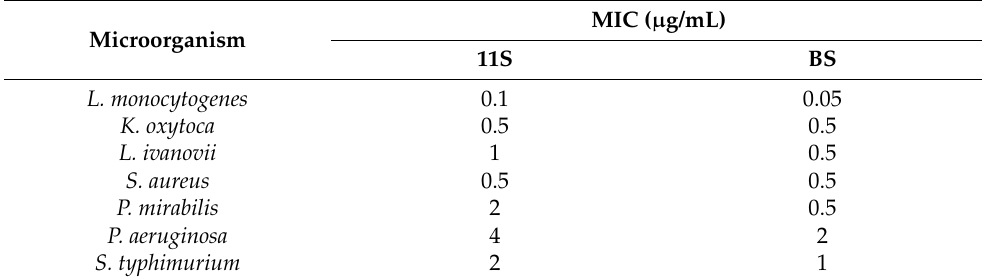
Table 3. Minimum inhibitory concentrations (MICs; µ g/mL) of 11S globulin and basic subunit (BS) from lupine seeds against tested bacteria.